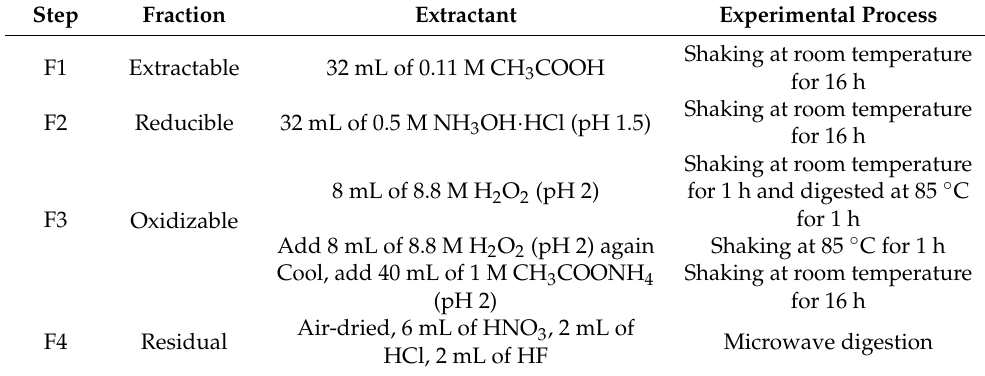
Table 1. Modified BCR continuous extraction method.